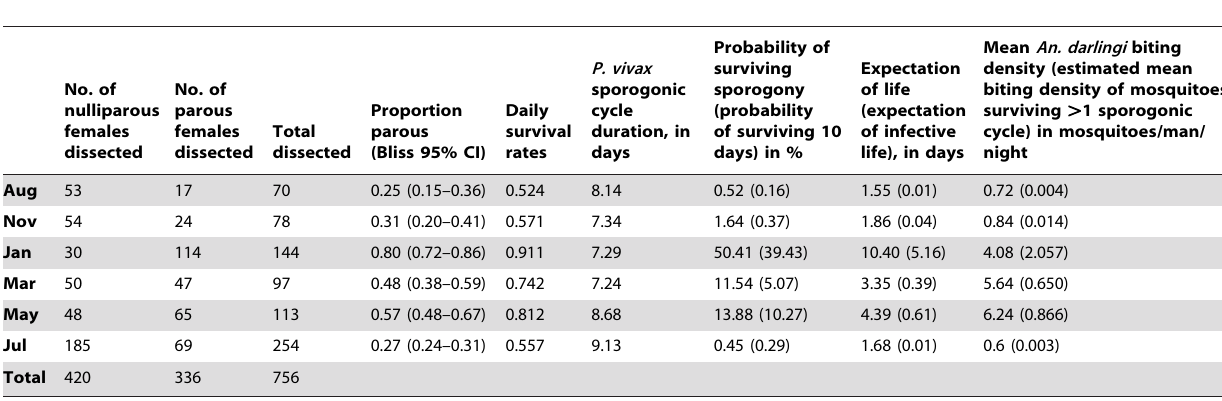
Table 3. Number of nulliparous and parous Anopheles darlingi females dissected in different collection periods, from August, 2003, to July, 2004.